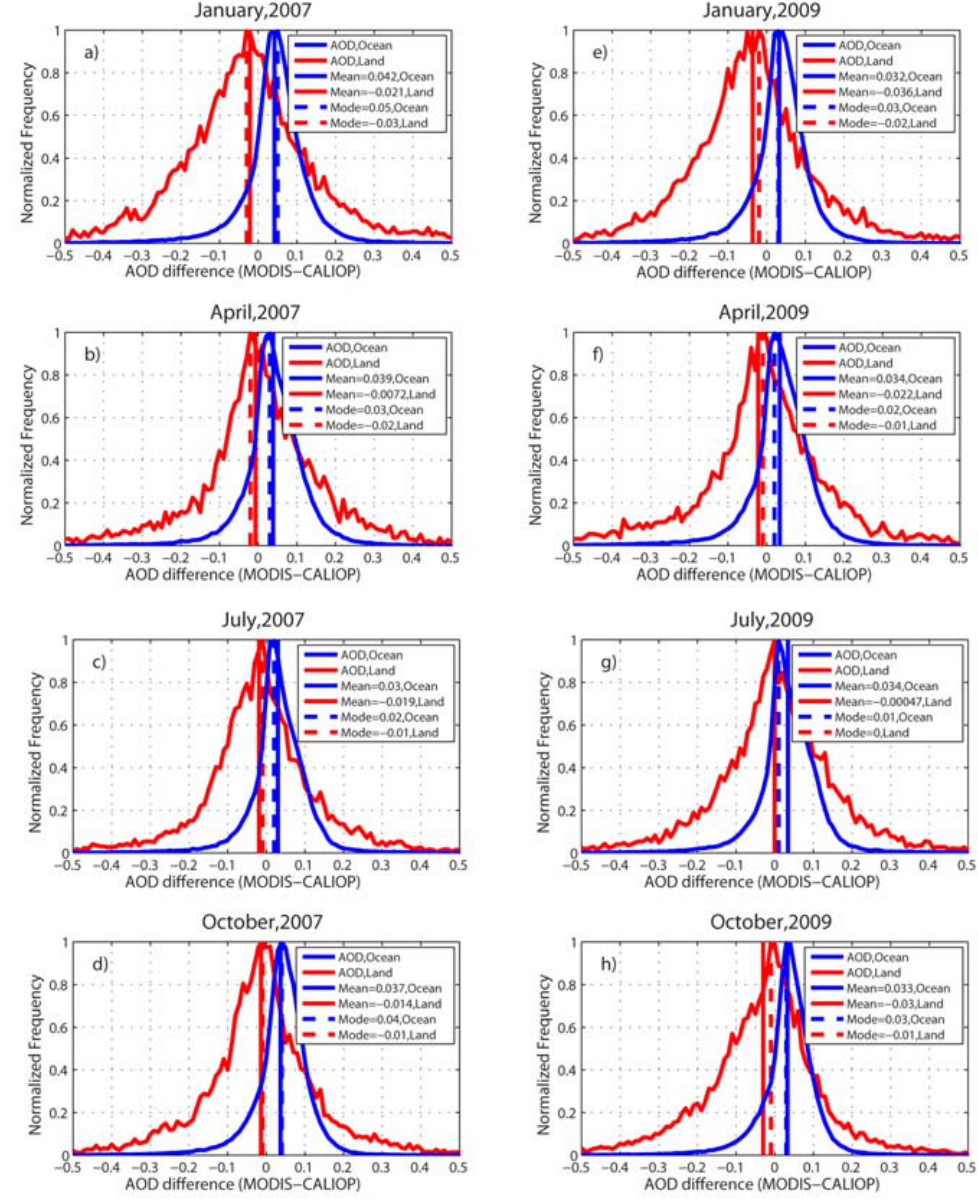
Fig. 5. (a) Frequency distributions of the difference between instantaneously collocated AOD retrievals of MODIS and CALIOP V3 for January 2007. Blue lines represent over-ocean comparisons; red lines represent over-land comparisons. Solid vertical lines indicate the mean and dashed vertical lines indicate the mode of the frequency distribution. (b) – (h) same (a) , but for different months in 2007 and